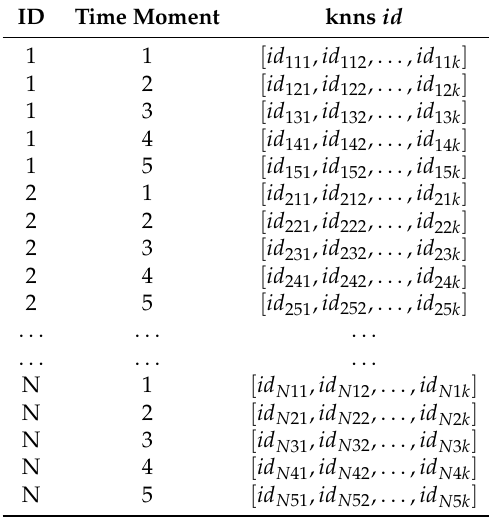
Table 3. k -Anonymity Sets for N Mobile Users in L = 5